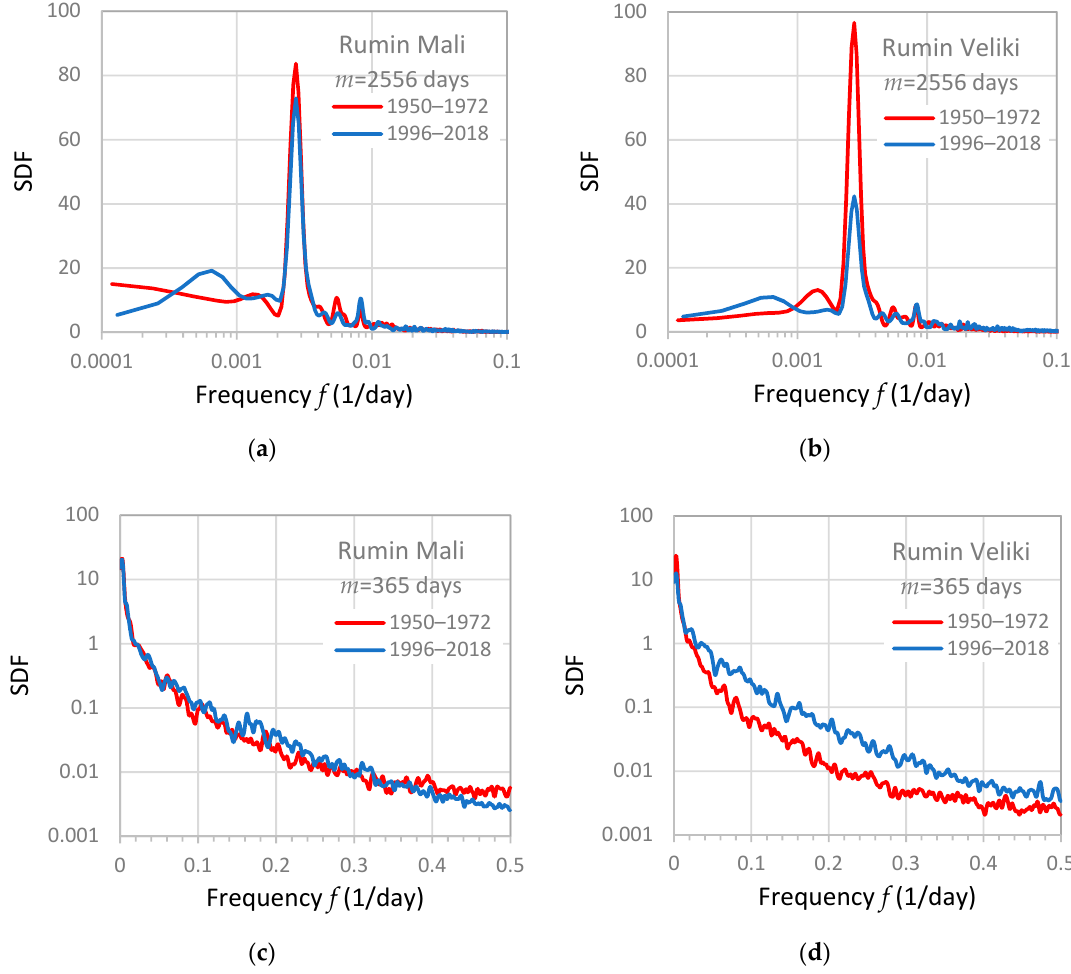
Figure 4. Spectral density function (SDF) of discharge for periods 1950–1972 and 1996–2018 for the springs Rumin Mali and Rumin Veliki for: ( a ), ( b ) low frequency range and truncation point of m = 2556 days, and ( c ), ( d ) high frequency range and truncation point of m = 365 days.